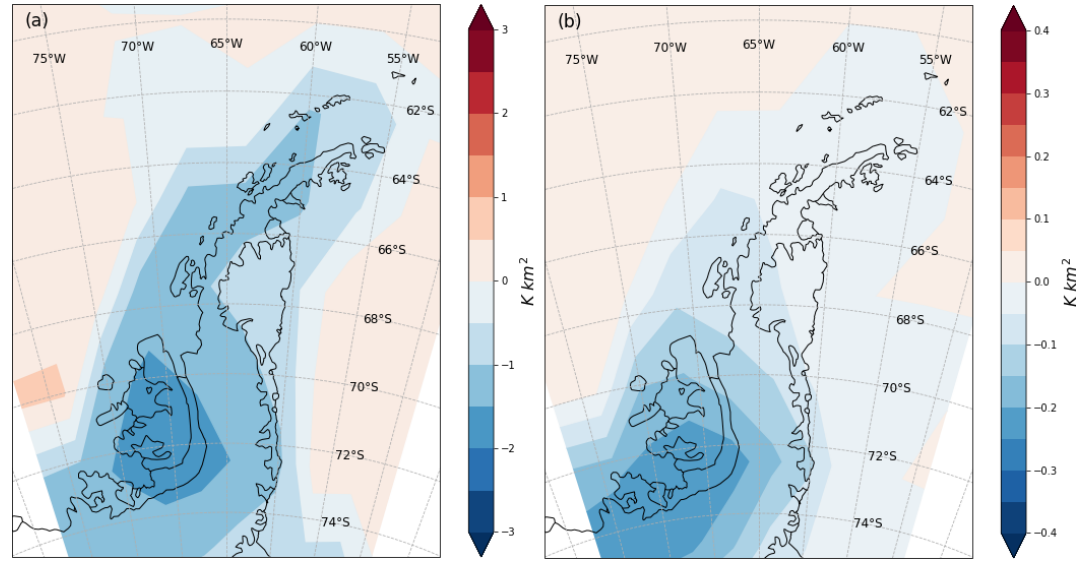
Figure 8. Maps of the differences in mean monthly FP (Kkm 2 ) between the perturbation run and the control run for the combined months of May to October over the Antarctic Peninsula at an altitude of 20.4km for PSCs composed of (a) NAT and (b) ice particles, i.e. the difference between using T equal to either T UM − UKCA + (cid:49)T − (perturbation run with the parameterisation scheme on) or T UM − UKCA (control SSO run with the parameterisation scheme off).